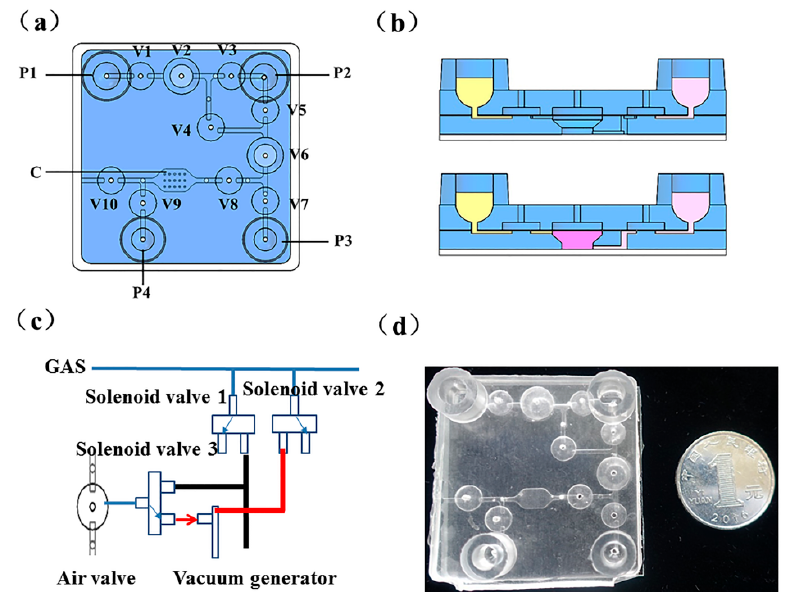
Figure 1. A schematic of the microdevice chip: ( a ) Top view of the chip; ( b ) The on-chip peristaltic pump consisted of three valves; ( c ) Solenoid valves for controlling the air circuit (on-off); ( d ) A photograph of the chip fabricated with polydimethylsiloxane (PDMS).